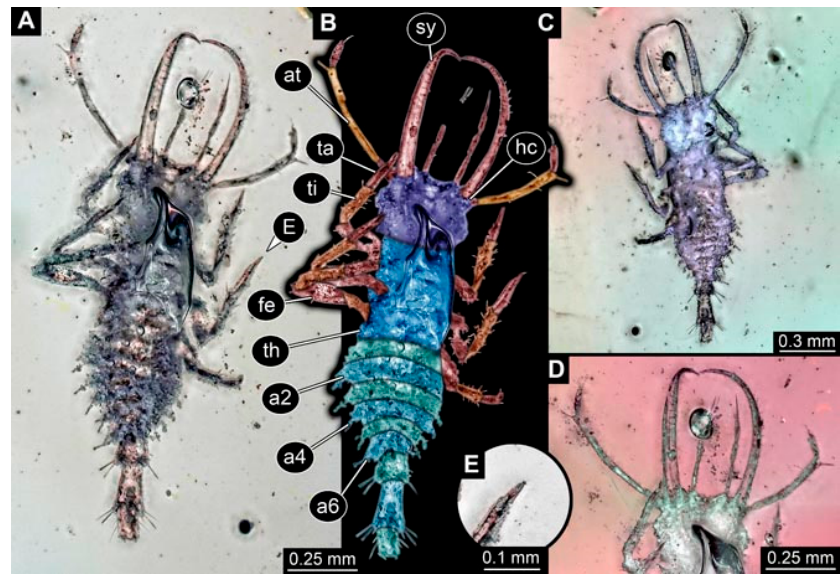
Figure 7. Specimen 4825 (BUB 3379); Myanmar amber. ( A ) Ventral view. ( B ) Ventral view, colour- marked. ( C ) Dorsal view. ( D ) Close-up of head capsule in ventral view. ( E ) Close-up of distal end of trunk appendage. Abbreviations: a2–a6 = abdomen segments 2–6; at = antenna; fe = femur; hc = head capsule; sy = stylet; ta = tarsus; th = thorax; ti = tibia.